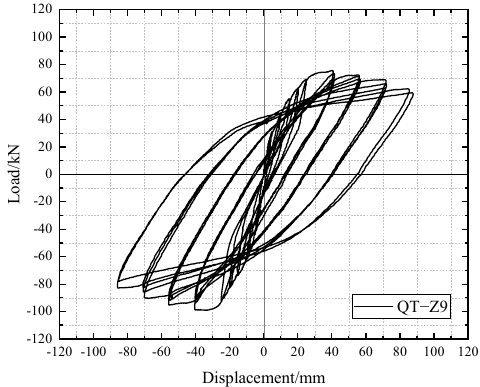
Figure 17. Load-lateral hysteresis curve of QT − Z9.